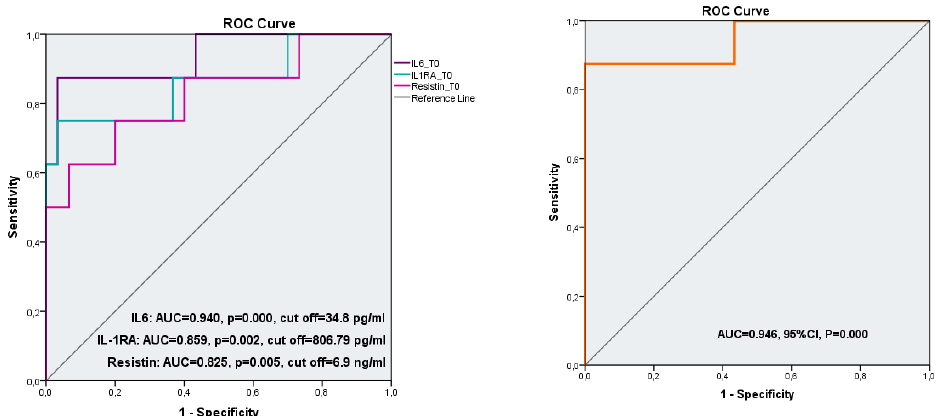
Figure 3. ROC curves of univariate variables (Il-6, IL-1RA, resistin) at admission for predicting LV ( left ); The ROC curve for risk prediction model (simultaneously including the three cytokines) ( right ).